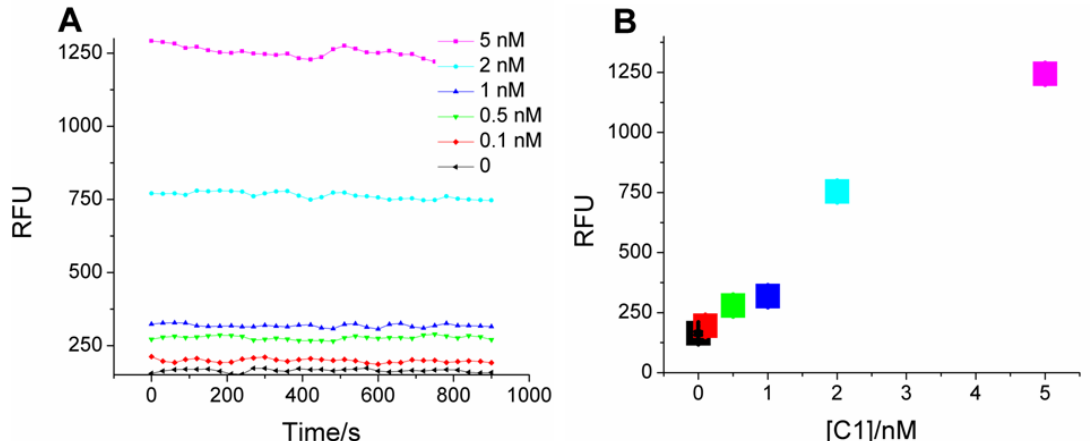
Figure 2. Kinetics of two-layer amplification by CHA-HCR. ( A ) Fluorescent kinetic curves after standard CHA-HCR two-layer amplfication; ( B ) Concentration dependence of C1 following standard CHA-HCR two-layer amplfication. The RFU for each concentration is the mean of all steady-state data points in Figure